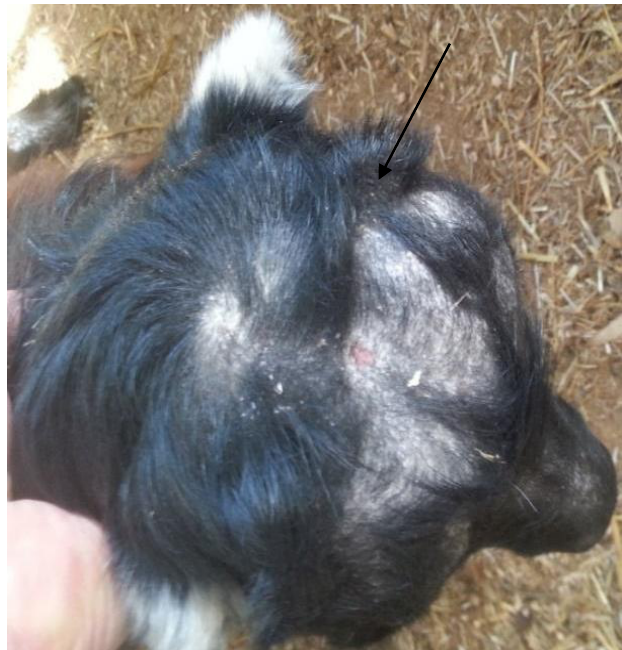
week (end of the th Goat on the 10 Figure 3.